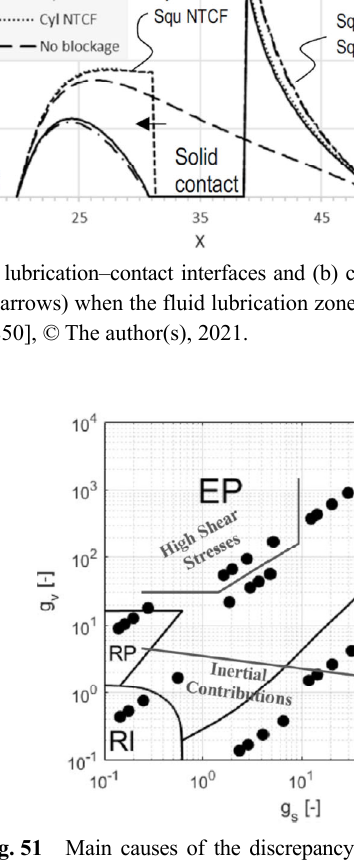
Fig. 51 Main causes of the discrepancy between the RBM and the NS approach [852]. Reproduced with permission from Ref. [852], © American Society of Mechnaical Engineers, 2021.